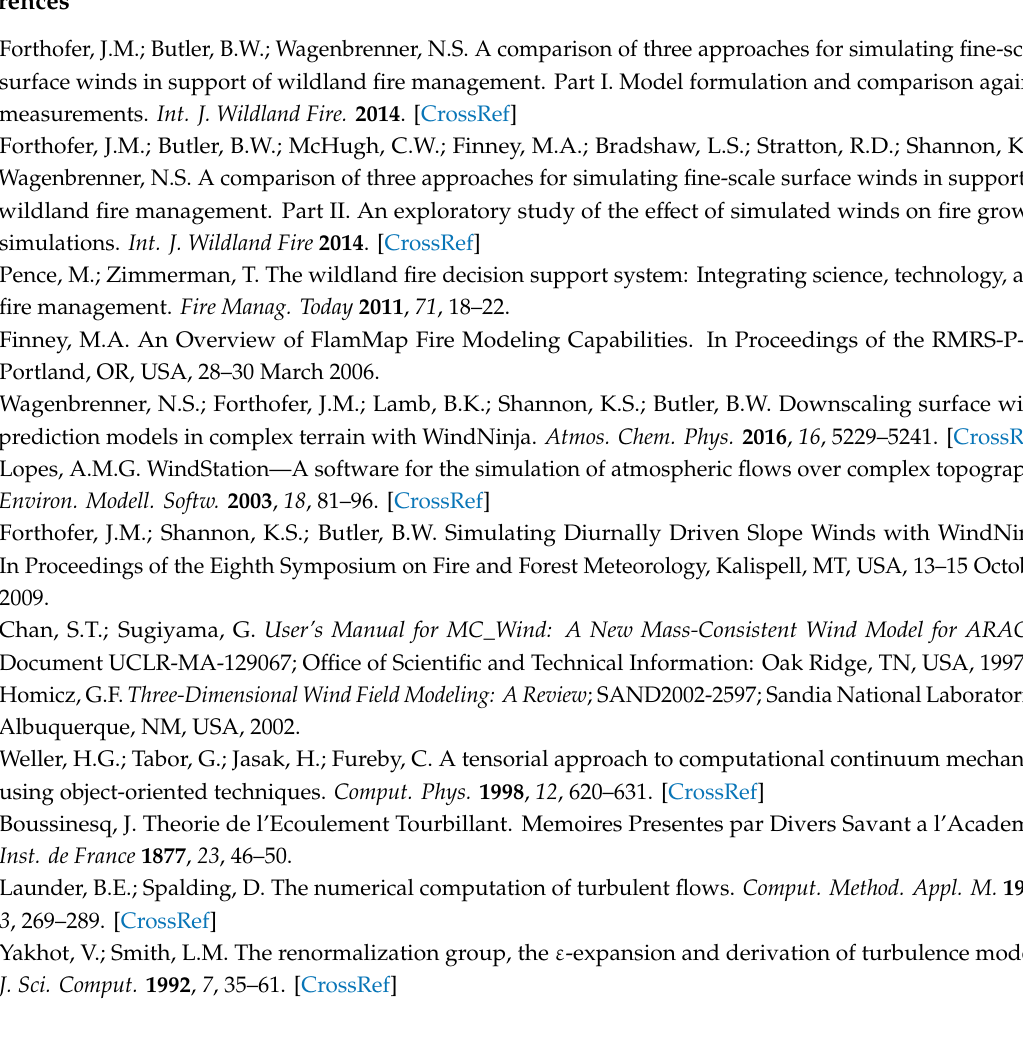
Figure A2. Model comparisons with observed data at 5 m above ground level at Bolund Hill for Case 3. KELU and KEQUICK are the results from the mesh used in this study with 100K cells; KELU_4Mcells and KEQUICK_4Mcells are the results from meshes with 4M cells. Black circles are observed data. The x-axis is distance along the transect. The y-axis is fractional speed-upc relative to the observed speed at a reference station upwind. The black dashed line is the COM solver results. Dotted black lines are LES results redrawn from Bechmann et al. [21] and Vuorinen et al. [37].